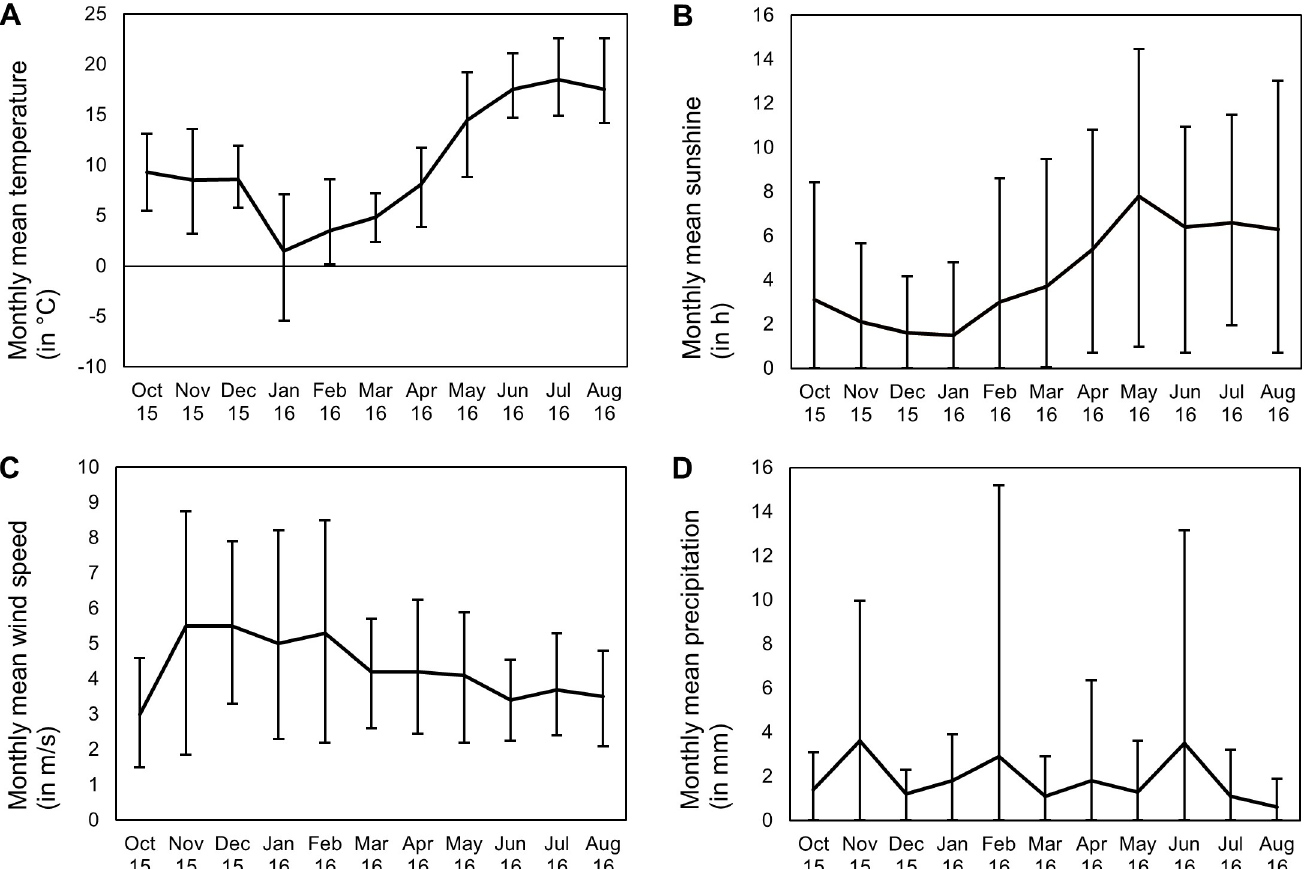
Fig 1. Monthly means and their 10 th and 90 th percentile of meteorological conditions during the observation period. (A) Temperature. (B) Sunshine. (C) Wind speed. (D) Precipitation.